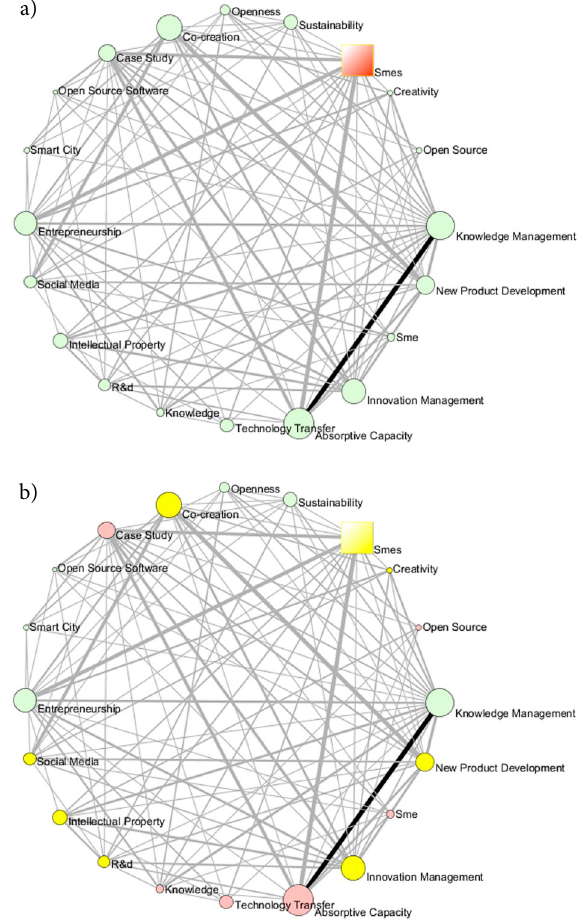
Figure 6. The co-occurrence network and clustering based on the top 20 high-frequency keywords: a – the co-occurrence network; b –